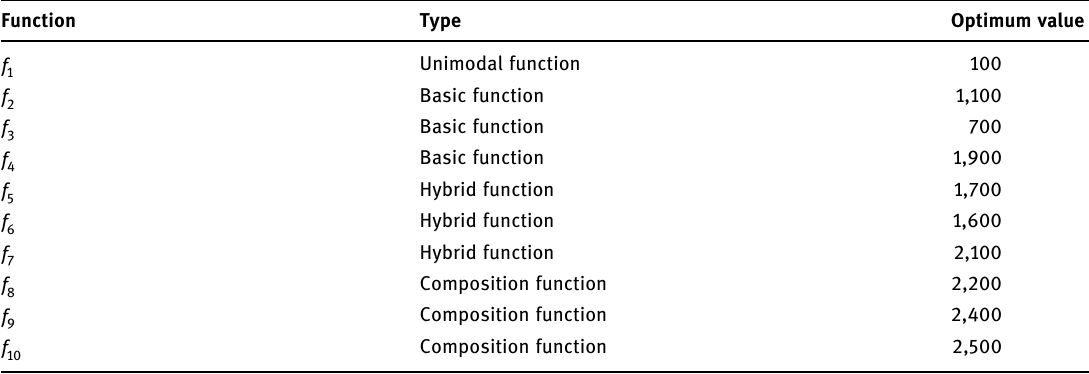
Table 1: Summary of the CEC 2020 benchmark functions Function